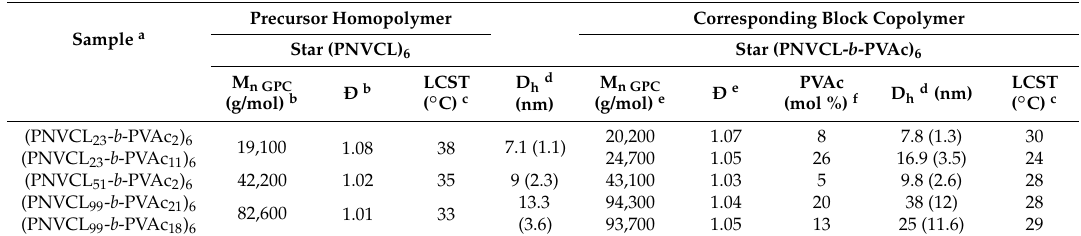
Table 2. Characteristics of the star (PNVCL- b -PVAc) 6 copolymers.